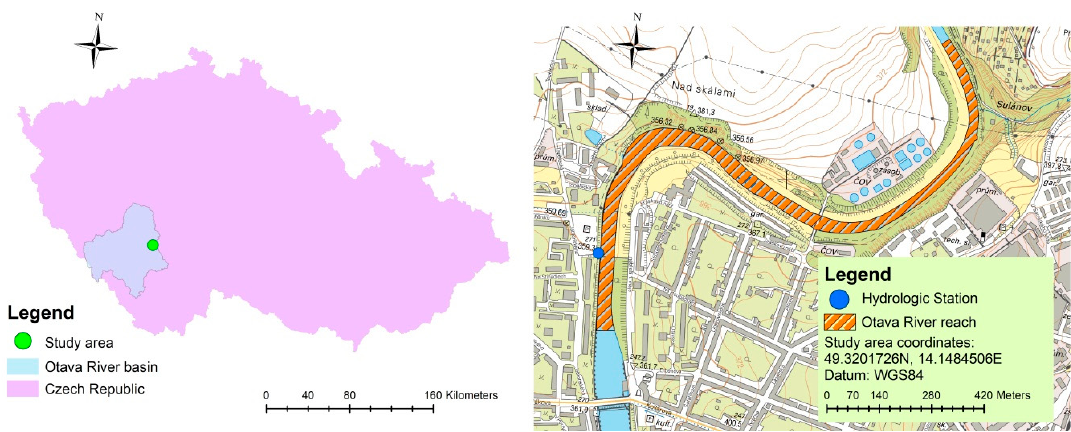
Figure 3. The study area: Otava River reach.